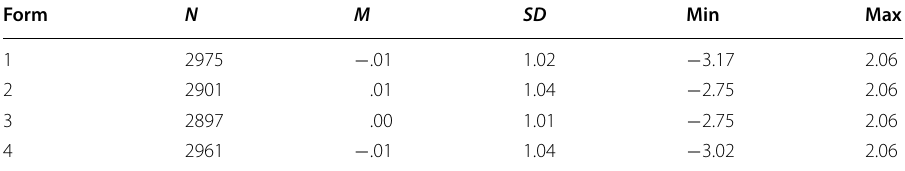
Table 3 Descriptive statistics of latent trait estimates from the Rasch model across four test